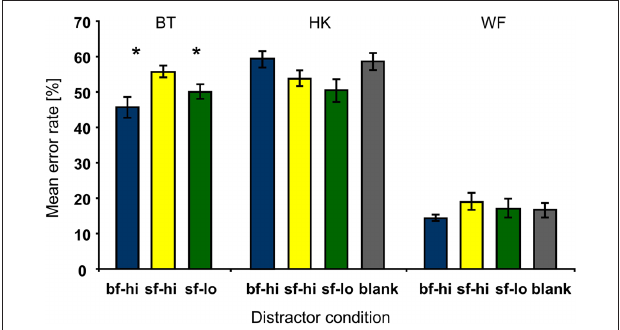
Figure 3 | Mean error rates per patient and distractor condition. Compared to the effects of both the low-contrast disk in the sighted (sf-lo, green) and the high-contrast disk in the blind field (bf-hi, blue), BT’s error rates were significantly higher when high-contrast distractors appeared in the sighted field (sf-hi, yellow). HK’s and WF’s data showed no effect that survived correction for multiple comparisons. WF made much fewer errors than BT and HK. Here as in subsequent figures distractor conditions are color coded; gray corresponds to the blank distractor condition. Asterisks indicate corrected P -value levels (* P < 0.05; ** P < 0.005; error bars represent ± corr. corr.